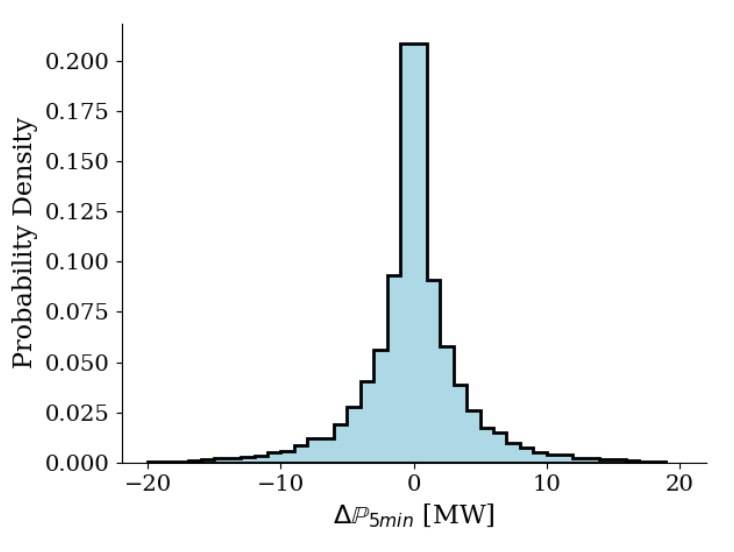
Figure 8. Frequency distribution of five minute power changes at the Mount Mercer wind farm during the assessment period (20 August 2020–01 November 2020). The bin width is 1 MW.